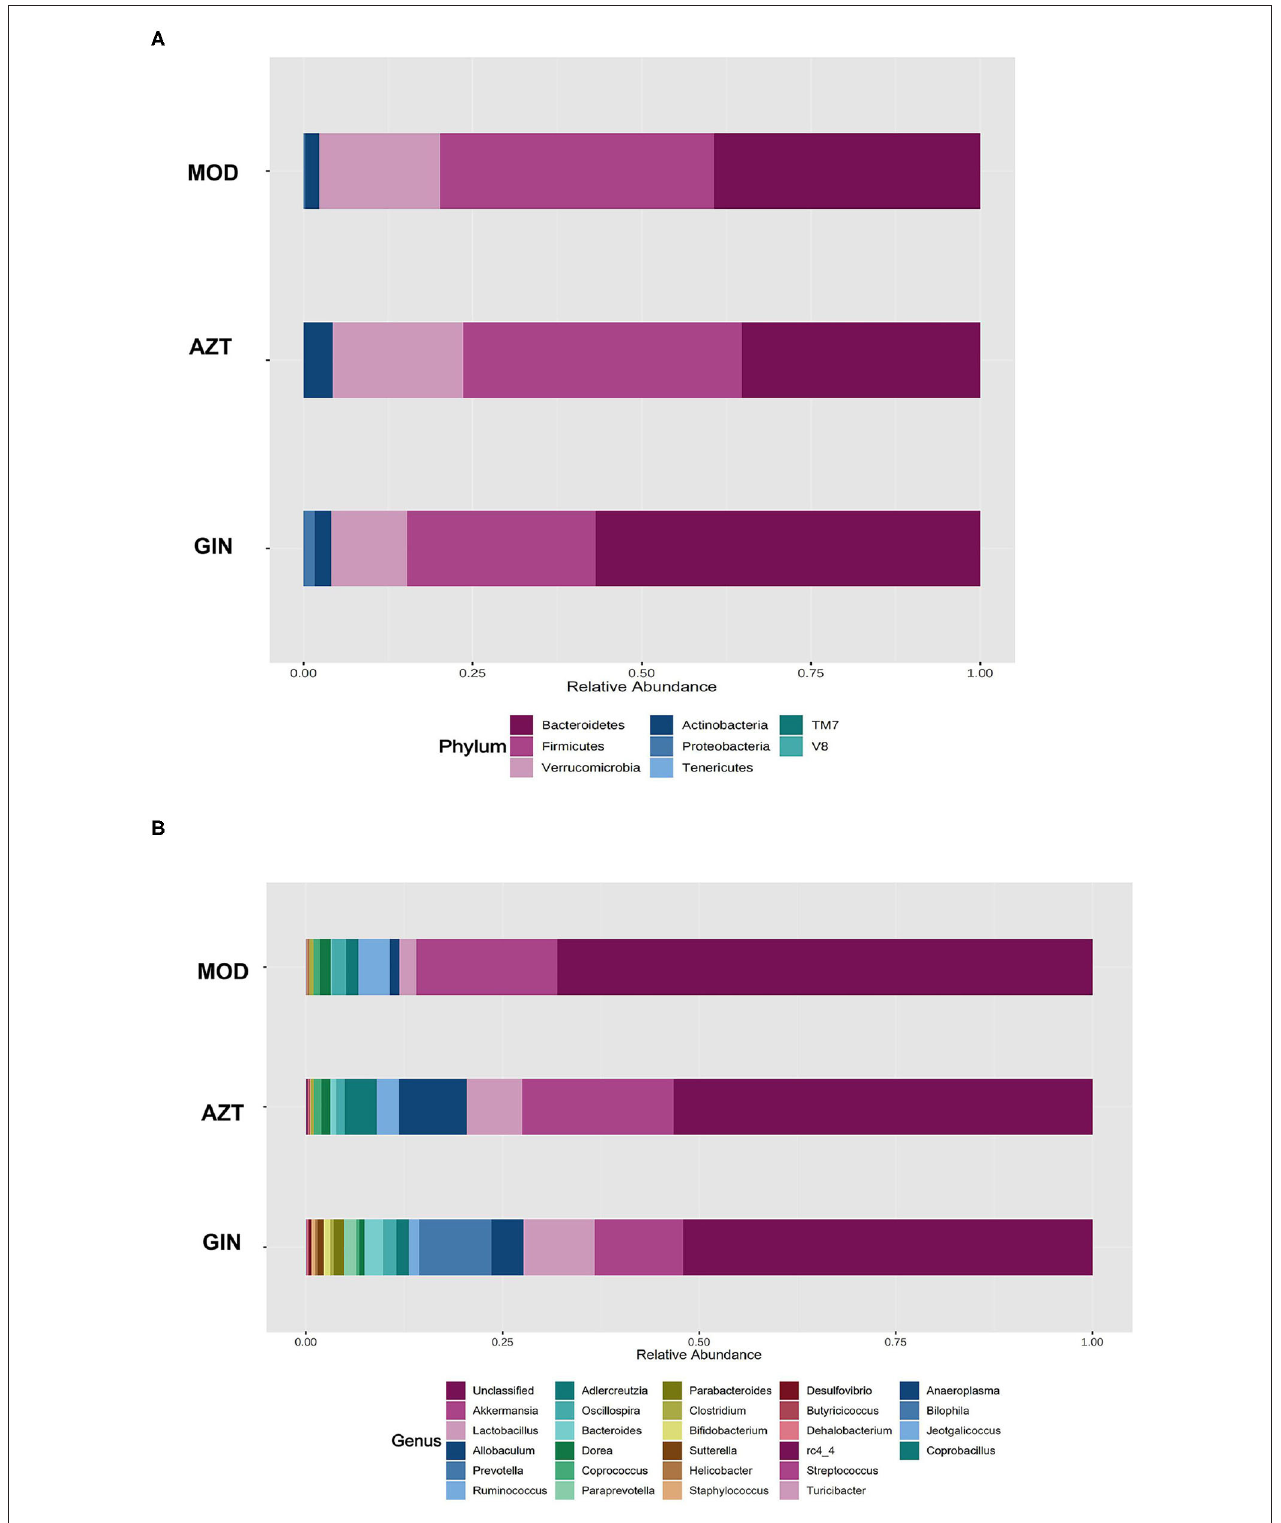
FIGURE 6 | Ginger modulates the composition of gut microbiota induced by early AZT exposure. (A) Microbial community bar plot by phylum. (B) Microbial community bar plot by genus.